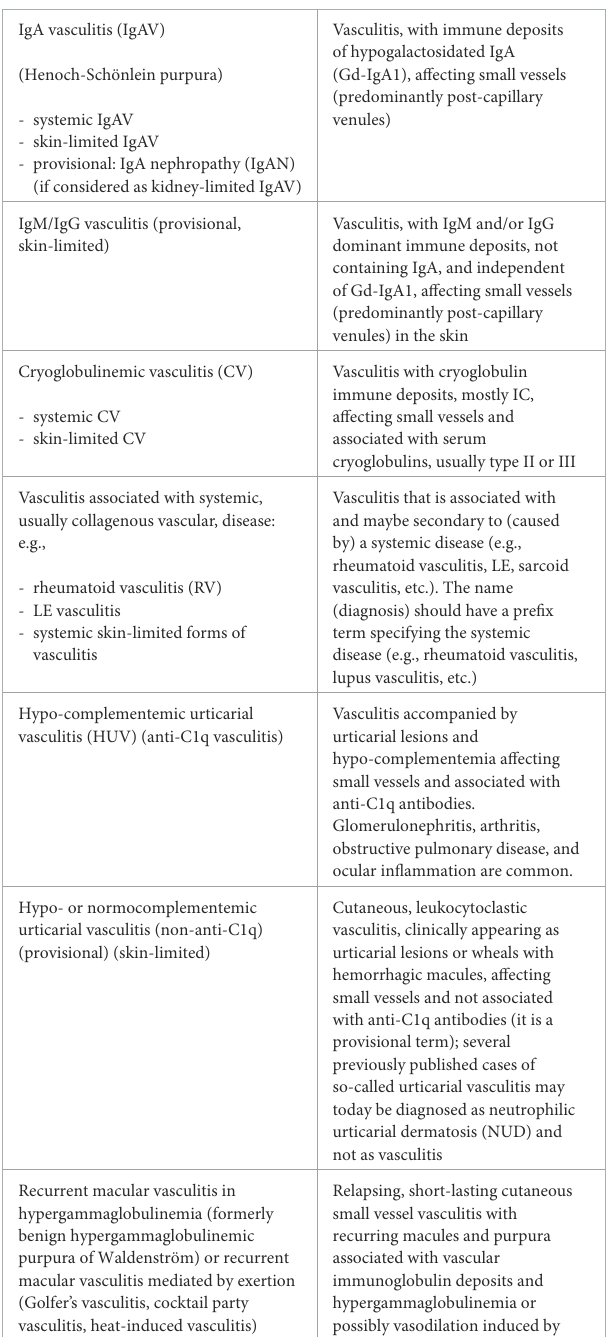
TABLE 1 Immune complex